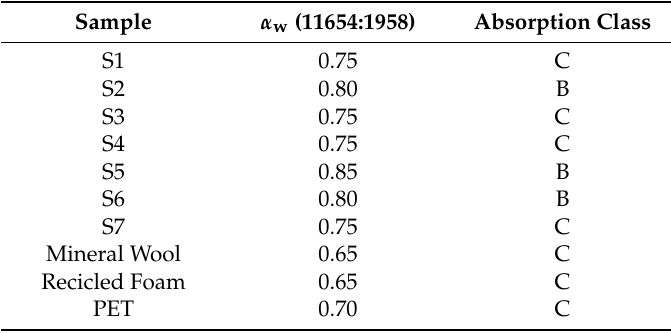
Table 4 . Measured rating of sound absorption according to ISO 11654. Table 4. Measured rating of sound absorption according to ISO